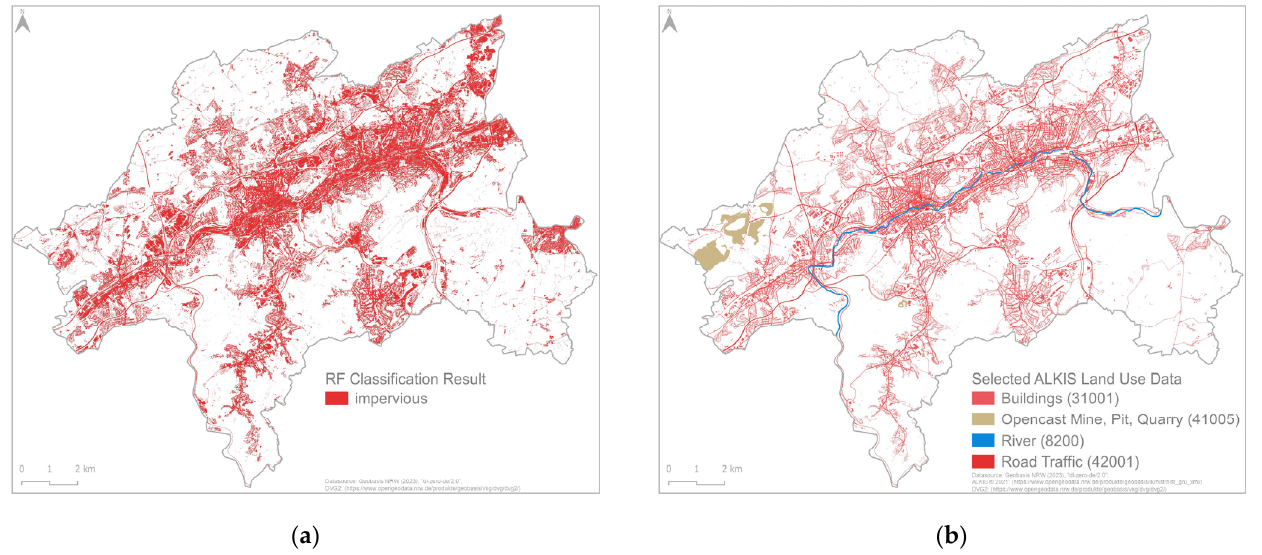
Figure 6. Illustration of ( a ) the produced RF classification results indicating impervious surfaces in the study area and ( b ) the selected and rasterized ALKIS land use data for superimposition.